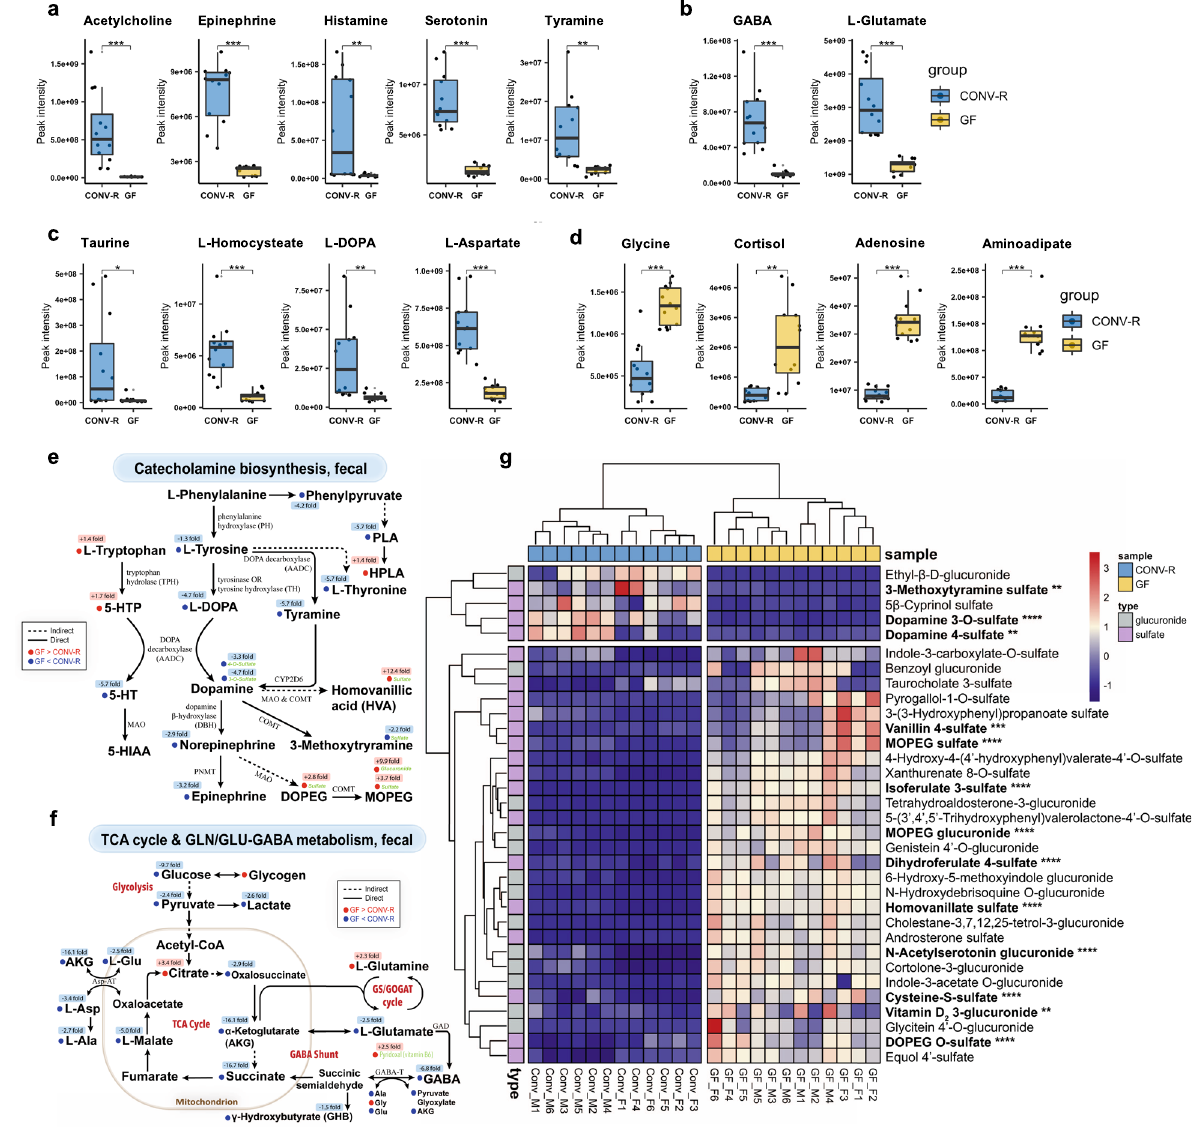
Fig. 4 Microbiota extensively mediates neurotransmitter production, deconjugation and transformation in the GI tract. a – d Box and Whisker plots of fecal Class A (Rhodopsin-like) GPCR amine neurotransmitters ( a ), fecal Class C metabotropic neurotransmitter L-glutamate and GABA ( b ), CONV-R enriched neurotransmitters and related molecules ( c ) and GF-enriched neurotransmitters and related molecules ( d ), with the box ranging from the fi rst quartile to the third while the whiskers going from each quartile to the minimum or maximum (GF, N = 12; CONV-R, N = 12), * p < 0.05, ** p < 0.01, *** p < 0.001, **** p < 0.0001, two-sided Welch ’ s t test; exact p -values and adjusted p values (i.e., q values) are provided in Supplementary Data 2. ( e ) Diagram summary of altered fecal catecholamine biosynthetic pathways due to microbiota, with the signi fi cantly altered metabolites labeled in red (GF>CONV-R) or blue (GF<CONV-R) (two-sided Welch ’ s t -test, fold change ≥ 1.5, p < 0.01). f Diagram summary of altered fecal (glutamine-)glutamate- GABA metabolism coupling with citric acid cycle due to microbiota, with the signi fi cantly altered metabolites labeled in red (GF>CONV-R) or blue (GF<CONV-R) (Welch ’ s t -test, fold change ≥ 1.5, p < 0.01). g Heatmap clustering of distinct fecal metabolites from Phase II reaction; glucuronides or sulfates of neurotransmitters or related compounds were labeled by bold texts with asterisks showing statistical signi fi cance. GABA γ -aminobutyrate, 5-HTP 5-hydroxy-L-tryptophan, 5-HT 5-hydroxytryptamine, 5-HIAA 5-hydroxyindoleacetate, PLA DL-3-phenyllactate, HPLA DL-p-hydroxyphenyllactate, DOPEG 3,4-dihydroxyphenylglycol, MOPEG 3-methoxy-4-hydroxyphenylglycol, MAO monoamine oxidase, CYP2D6 cytochrome P450 2D6, COMT catechol-O-methyltransferase, TCA cycle tricarboxylic acid cycle, Gln/Glu-GABA metabolism glutamine/glutamate- γ -aminobutyrate metabolism, AKG α - ketoglutarate, L-Asp L-asparagine, L-Ala, L-alanine, GS/GOGAT cycle glutamine synthase/glutamate:2-oxoglutarate aminotransferase cycle, Gly L-glycine, GABA-T 4-aminobutyrate transaminase, GAD glutamic acid